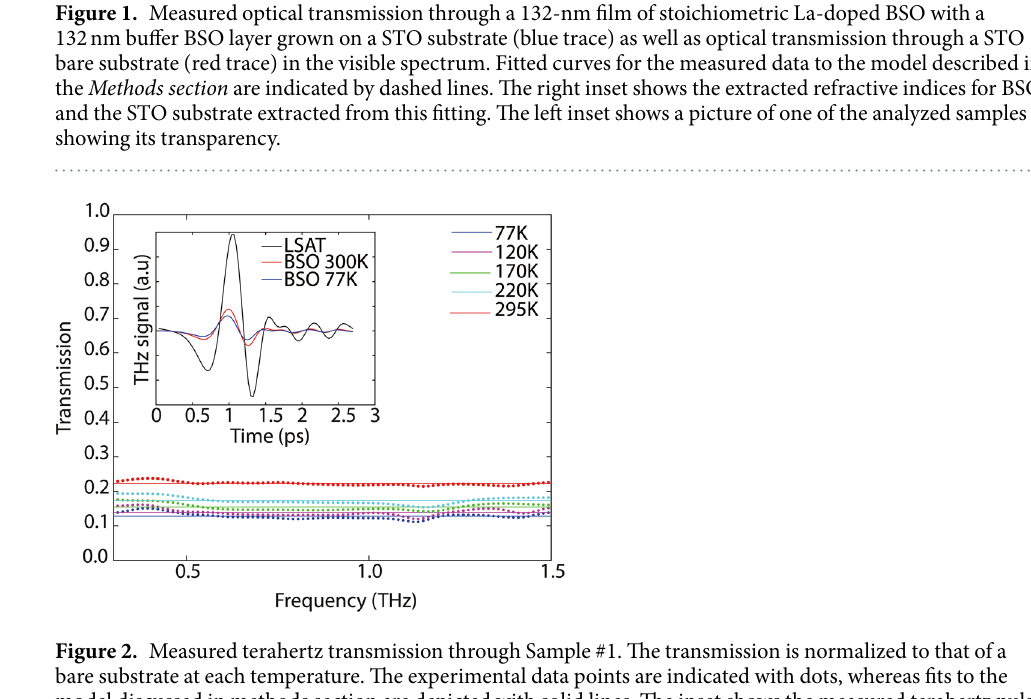
Figure 2 depicts the normalized transmission for Sample #1 at different temperatures (77 K, 120 K, 170 K, 220 K and 295 K) in the 0.3 to 1.5 THz frequency range. The inset in Fig. 2 shows the time domain pulses meas- ured for the reference LSAT substrate and the attenuated transmitted signal through the BSO/LSAT sample (at room temperature and 77 K). Frequency domain transmission properties are extracted from the Fourier trans- form of the normalized THz transmission through the substrate, allowing for extraction of the THz conductivity. As Fig. 2 shows, the transmission levels decrease as the temperature is decreased. This observation indicates an increase in the film conductivity as the temperature is decreased. Furthermore, the transmission is relatively flat in this frequency range. This observation is indicative of a short carrier momentum relaxation time; even with an increase in mobility at low temperatures, the momentum relaxation time is still relatively short and does not lead to spectral signatures in the analyzed frequency range. From the transmission data, we extracted the refractive index and absorption coefficient following the pro- cedure discussed in the Methods section. Figure 3 shows these extracted values, which were found to be rela- tively high when compared to reported values for ITO 9 . The behavior of these parameters, together with the flat spectral response obtained in the THz-TDS measurements, see Fig. 2, is an indication of metal-like behav- ior in these degenerate-doped semiconductors. We can also extract the THz-extracted AC conductivity for the film from the transmission data 27 . Figure 4 depicts the AC conductivity at THz frequencies for Sample #1 , as a function of temperature. Each transmission measurement was normalized to the measured transmission through the LSAT substrate at corresponding temperatures. The increase in conductivity with the decrease in